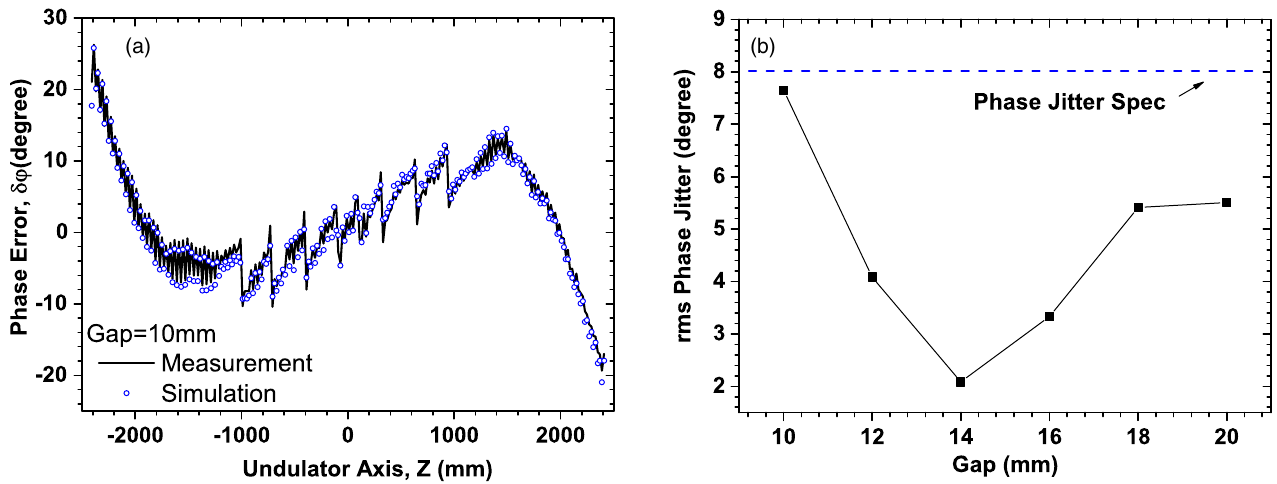
FIG. 12. (a) Black curve: Measured phase error δ φ after tuning. Blue open circles: Simulation of Fig. 11 shifted by 24° to match scales. (b) Final gap dependence of the rms phase jitter as a function of the undulator